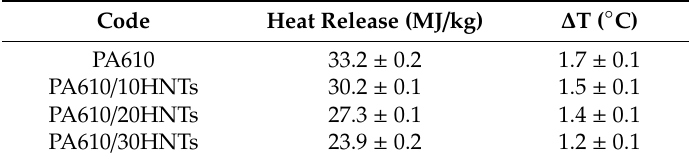
Table 8. Summary of calorific values results obtained in the PA610/HNT samples.